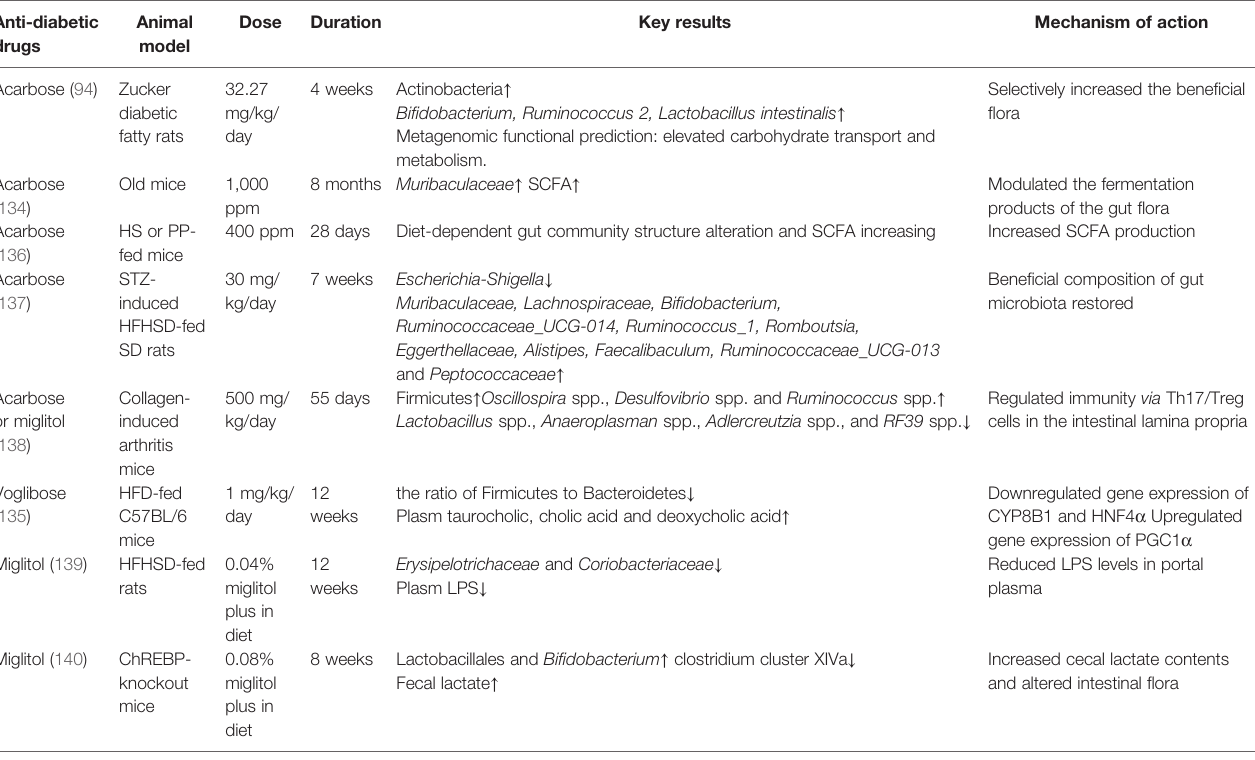
TABLE 4 | Experimental animal studies analyzing the effects of a -glucosidase inhibitors on gut microbiota. Anti-diabetic Animal drugs